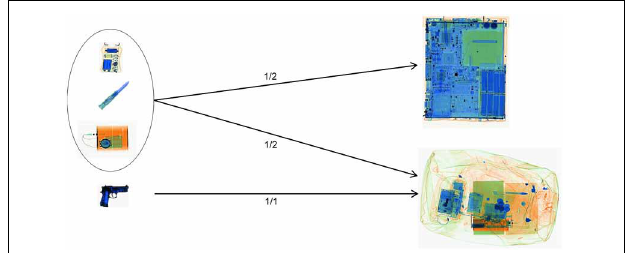
FIGURE 3 | Placement of the threat